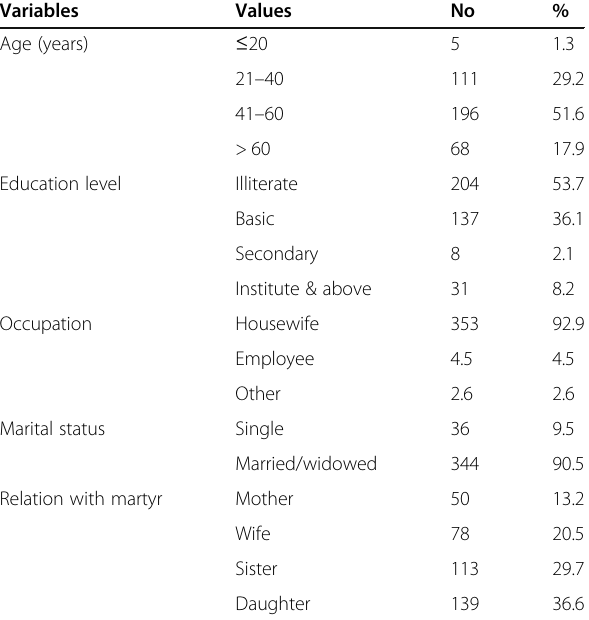
Table 1 Sociodemographic characteristics of the study sample Variables